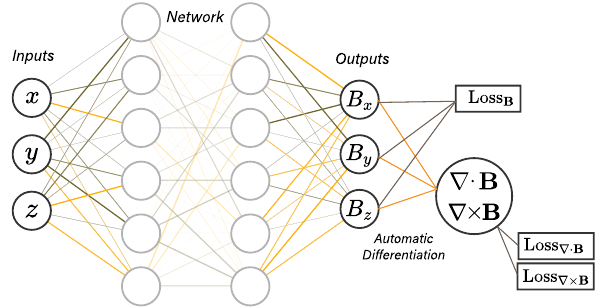
Figure 2. Network takes 3 inputs, ( x , y , z ) coordinates, and outputs the magnetic field B . Automatic differentiation is used to calculate the exact derivatives of the output B with respect to the input